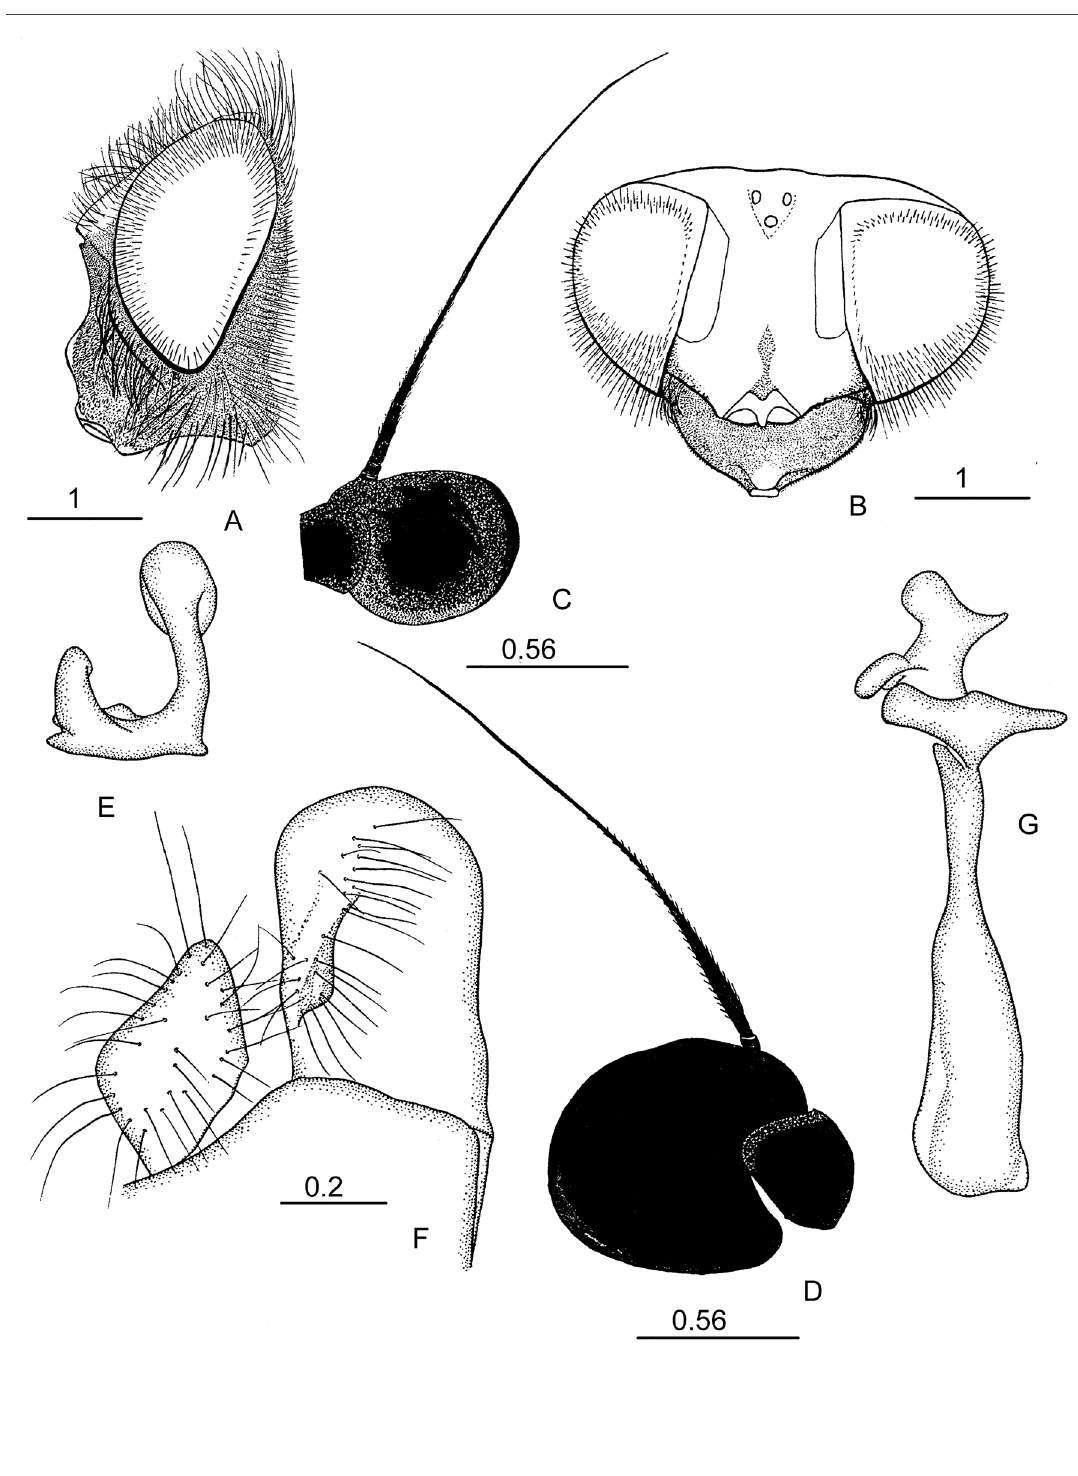
Fig. 15. Cheilosia ( Montanocheila ) distincta Barkalov & Cheng, 1998. A . Head of ♂, lateral view. B . Head of ♀, dorsal view. C . Antenna of ♂, lateral view of pedicel and basoflagellomere. D . Antenna of ♀, lateral view of pedicel and basoflagellomere. E . Superior lobe of hypandrium, lateral view. F . Surstylus and gonocercus, lateral view. G . Aedeagus and aedeagal apodeme, lateral view. After Barkalov & Cheng 1998. Scale bars indicated in